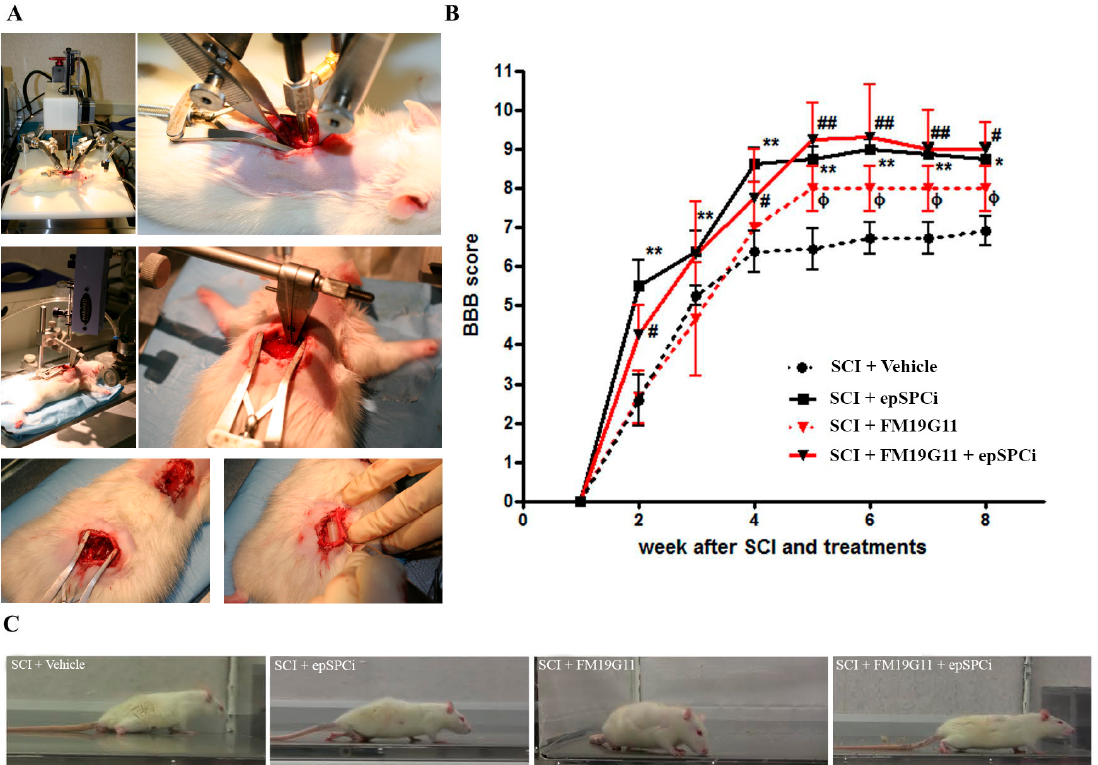
Figure 1. FM19G11, epSPCi or the combination of both improve locomotion in severe spinal cord injury (SCI) in comparison with the control group. ( A ) Surgery strategy to induce severe SCI by a 250-kdyn impact and acute transplantation by intramedullary injection of epSPCi and intrathecal catheterization for local and sustained delivery of FM19G11 using an osmotic pump; ( B ) functional locomotor analysis (BBB scores) over eight weeks post-treatment with vehicle, as a control, epSPCi, FM19G11 or FM19G11 + epSPCi; quantitative data are expressed as the mean ± S.E.M.; *, or #, or φ , p < 0.05, ** or ##, p < 0.01; ( C ) representative capture images from video recordings of one animal of every group for BBB analysis at the eighth week after SCI are shown as follows: SCI + vehicle (control), SCI + epSPCi, SCI + FM19G11, SCI + FM19G11 + epSPCi.